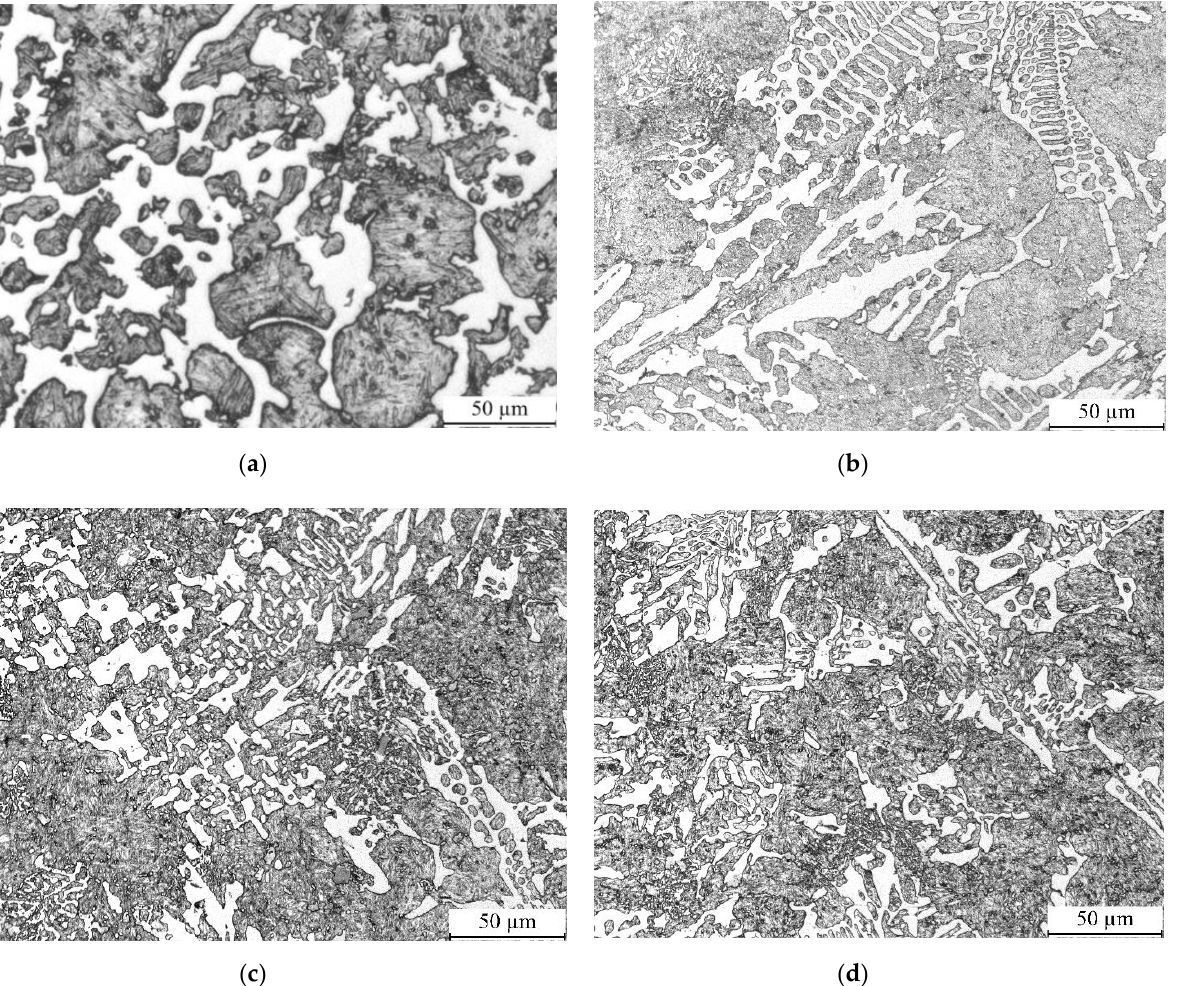
Figure 5. Morphologies of heat-treated high-boron multi-component alloy with various Ti contents: ( a ) M, 0.0 wt.%, ( b ) T1, 0.2 wt.%, ( c ) T2, 0.4 wt.%, ( d ) T3, 0.6 wt.%.